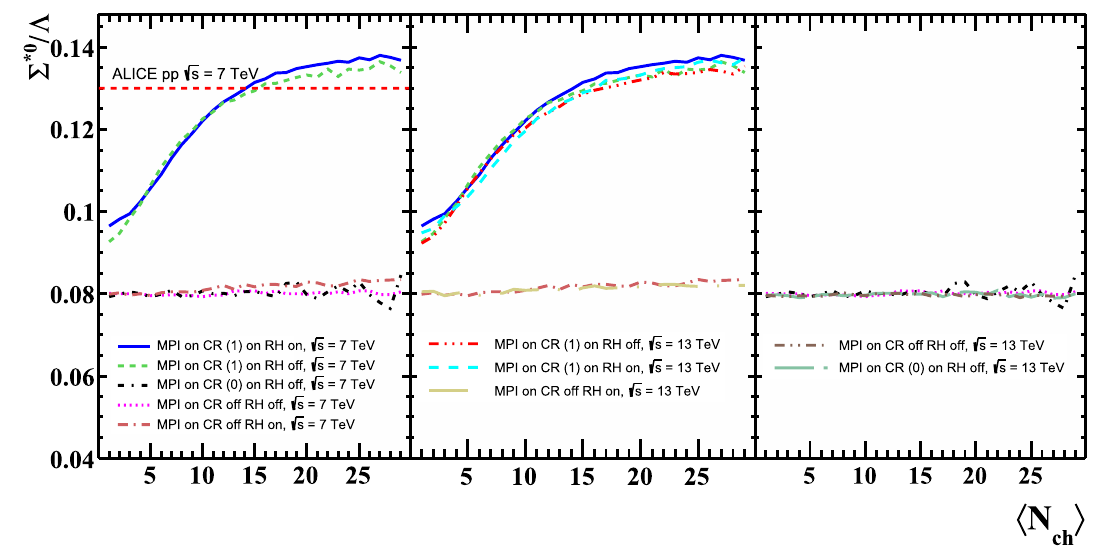
Fig. 8 p T -integrated ratio of (cid:8) 0 ∗ /(cid:4) as a function of < N ch > in p–p collisions. (Left panel) The ratios are compared for two different modes of color reconnections [CR-off, CR(0) and CR(1)] with (and without) √ s = 7 TeV. (Middle panel) The ratios are RH in p–p collisions at √ s = 7 TeV and 13 TeV for CR-off, compared for p–p collisions at